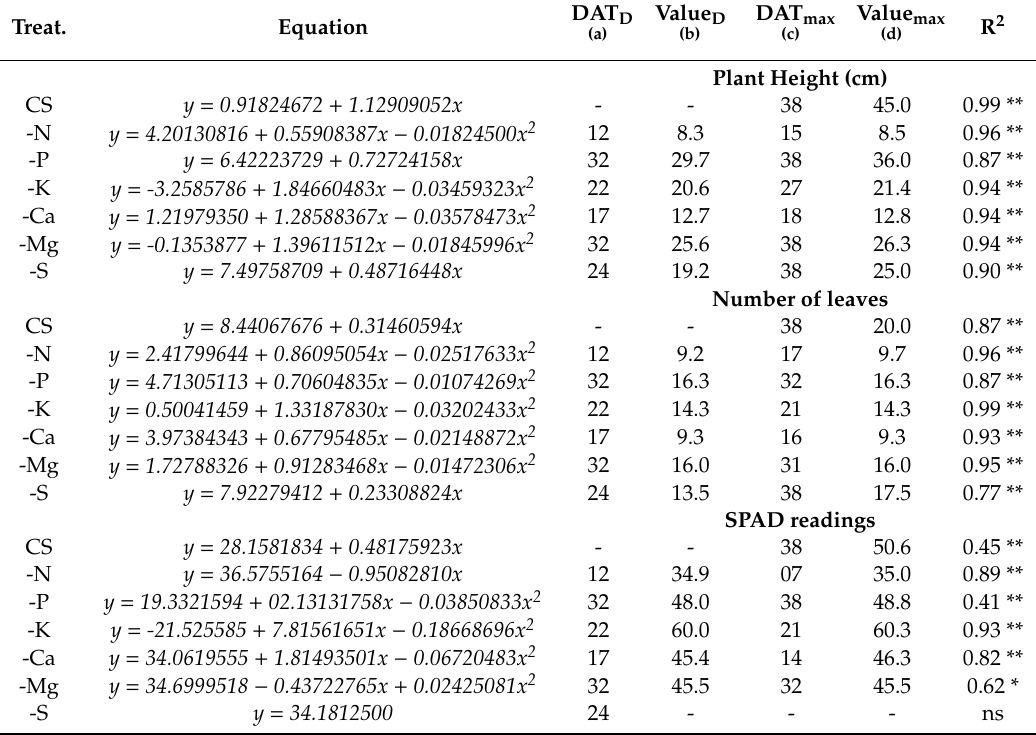
Table 2. Height, number of leaves and SPAD readings of broccoli ( Brassica oleracea var. italica L.) plants grown under macronutrient omission in nutrient solution.